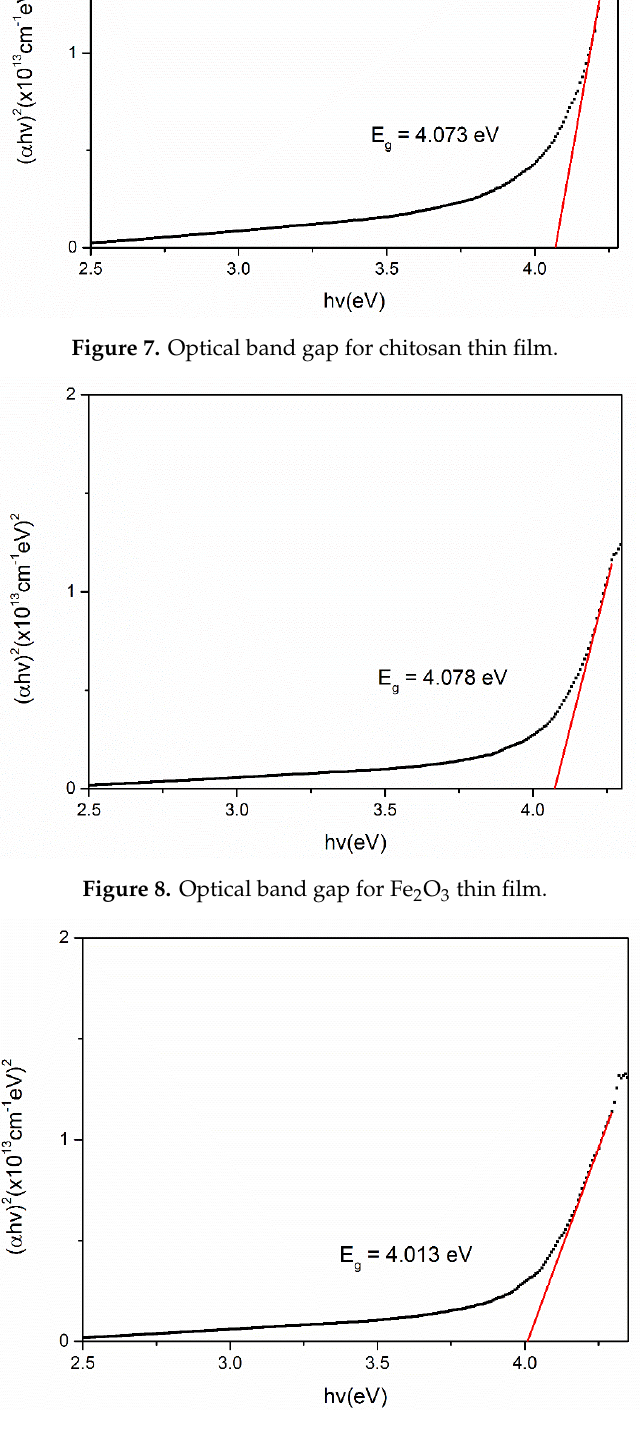
Figure 9. Optical band gap for Cs / Fe 2 O 3 thin film.